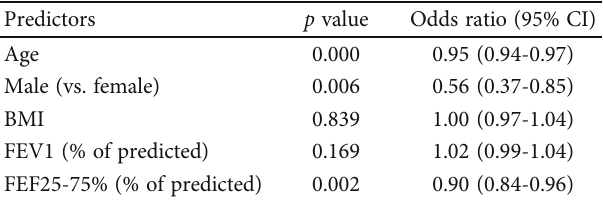
Table 2: Logistic regression results.